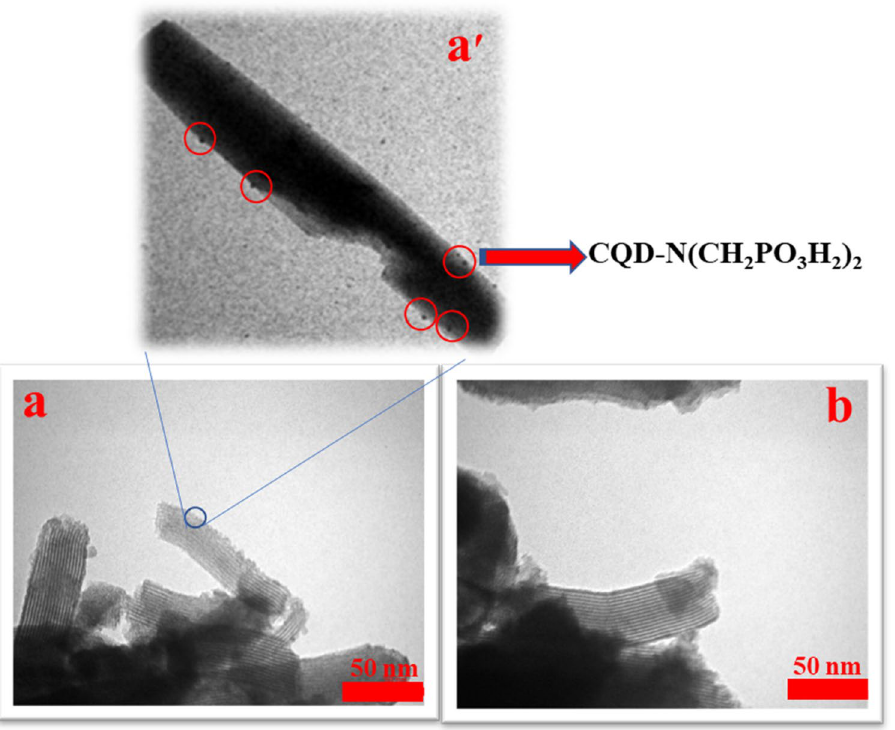
Figure 9. Transmission electron microcopy (TEM) images of CQDs-N(CH 2 PO 3 H 2 ) 2